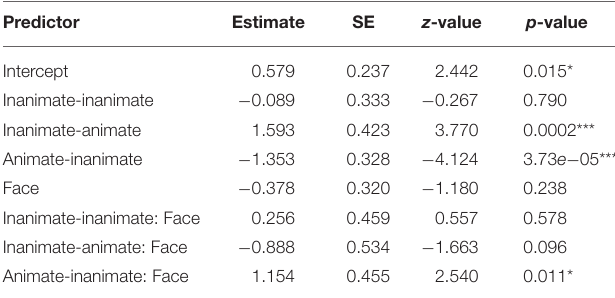
TABLE 2 | Child verbal response results: Mixed-effects modeling of verbal response to comprehension questions indicating subject noun vs. object noun interpretation of ambiguous pronoun.